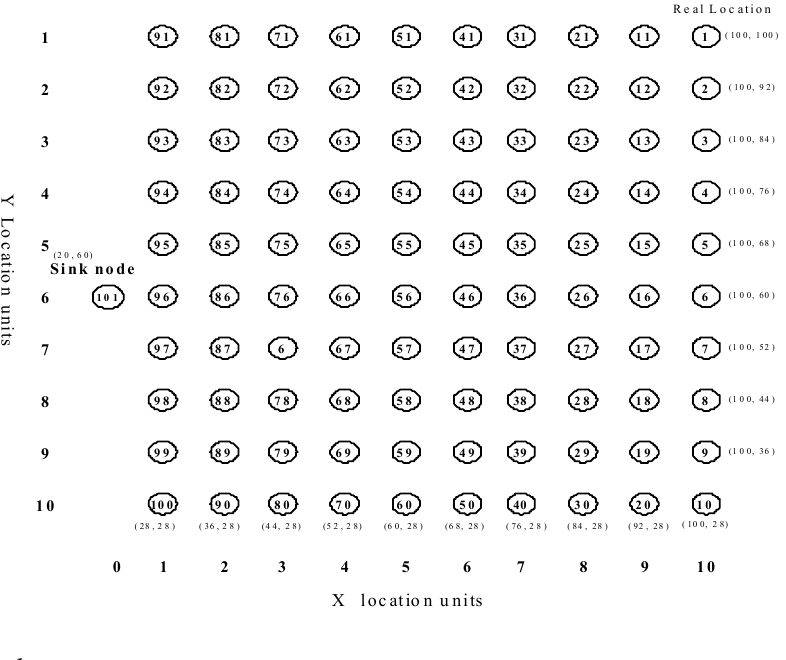
Figure 5. Simulation